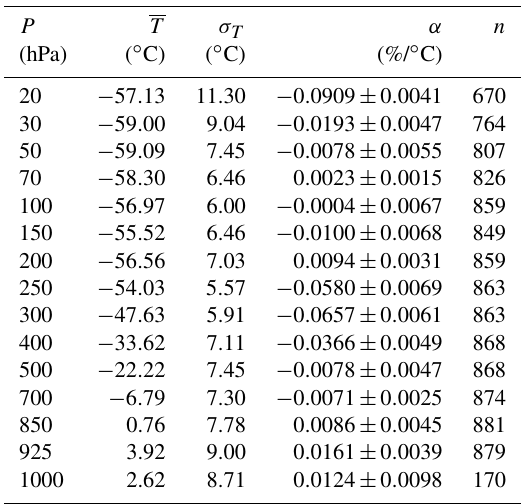
Table 1. The results of determining the temperature coefficient for each isobaric